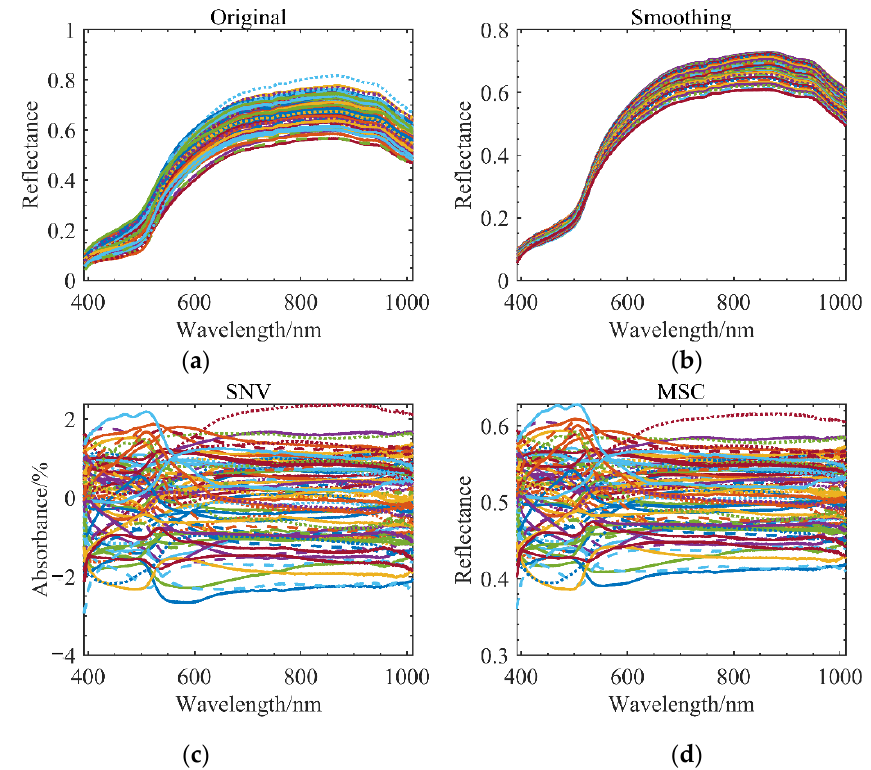
Figure 7. Spectral curve preprocessing: ( a ) original spectral curve; ( b ) spectral curve after smoothing; ( c ) spectral curve after SVN; ( d ) spectral curve after MSC.